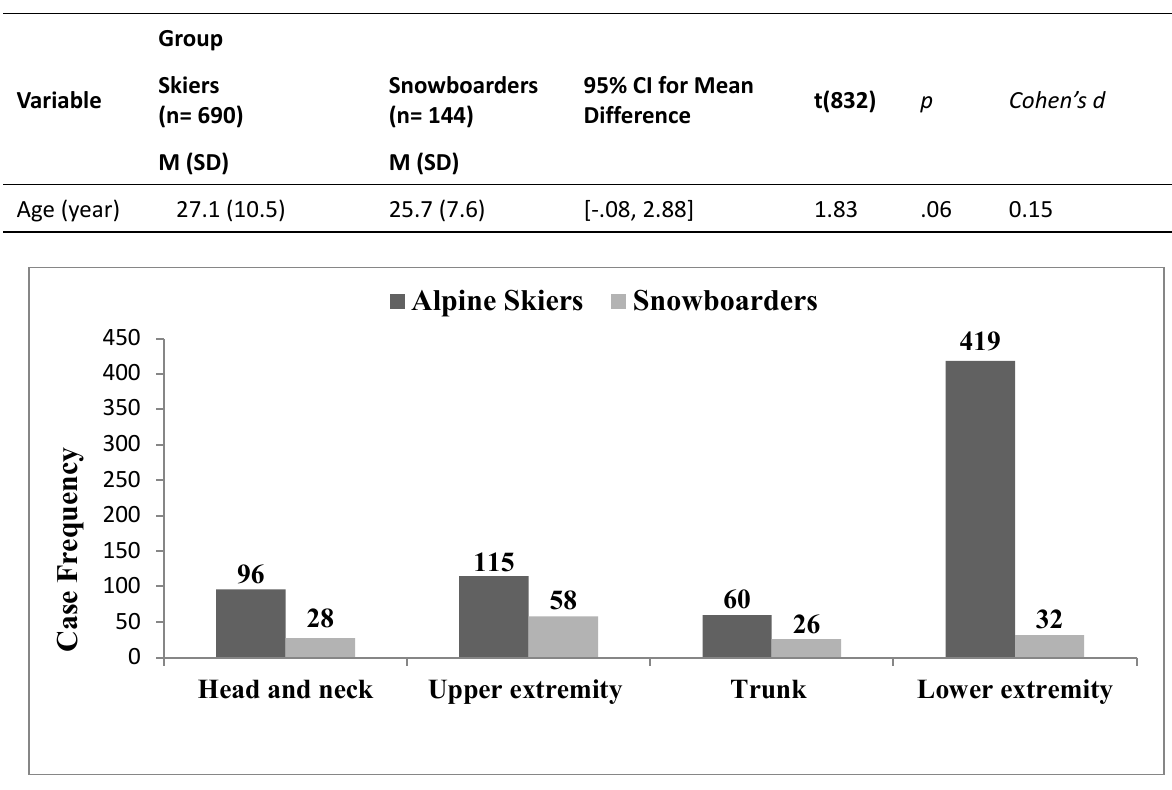
Table 1. The comparison of the mean age between groups.